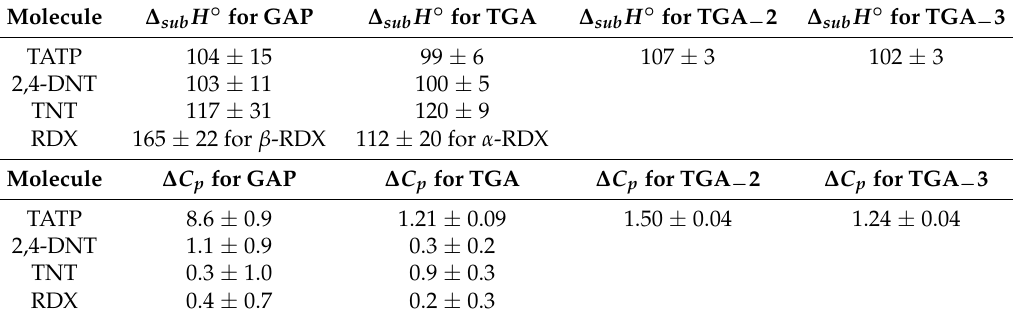
Table 2. Enthalpies of sublimation for standards (kJ/mol) and ∆ C p (kJ/mol · K) for HEMs. Molecule